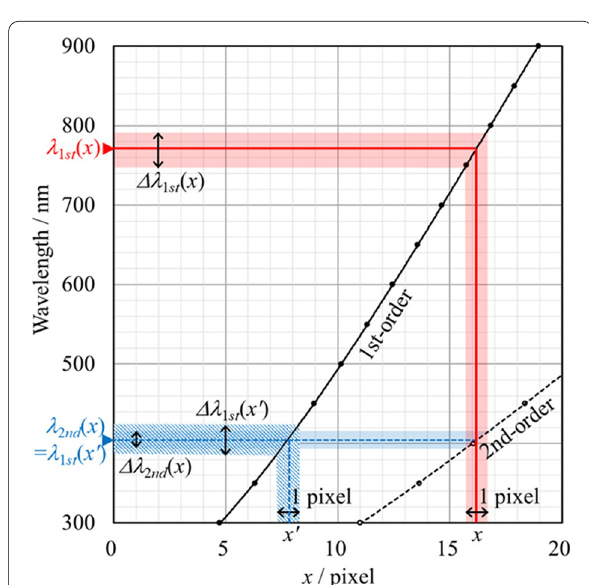
Fig. 11 The relationship between the distance from the center of count in Fig. 8 and wavelengths for the 1st- (solid line) and 2nd-order (broken line) spectral images. Because of the atmospheric dispersion, the relationships are non-linear. Therefore, cubic polynomial lines were best fitted to the plots. See text for